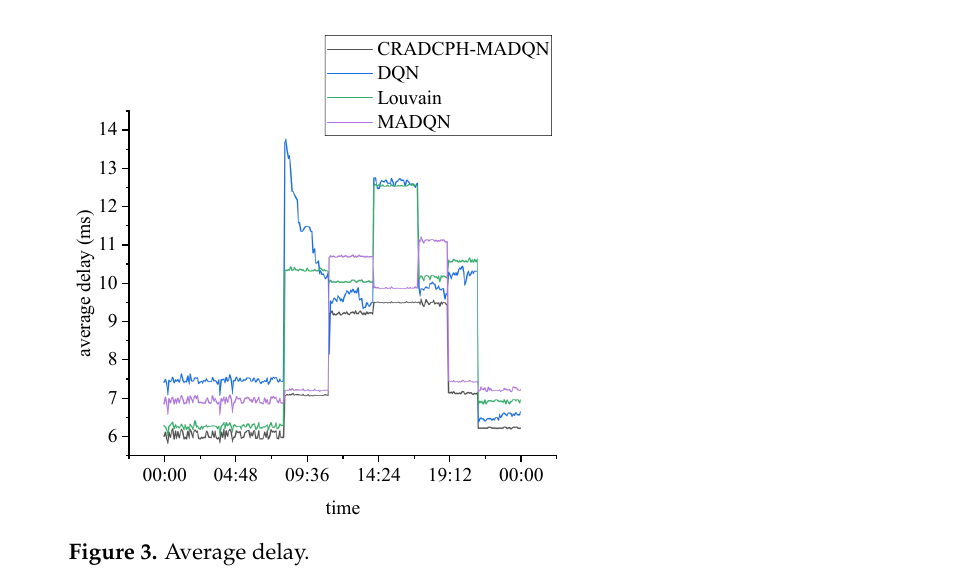
Figure 5. Control reliability.